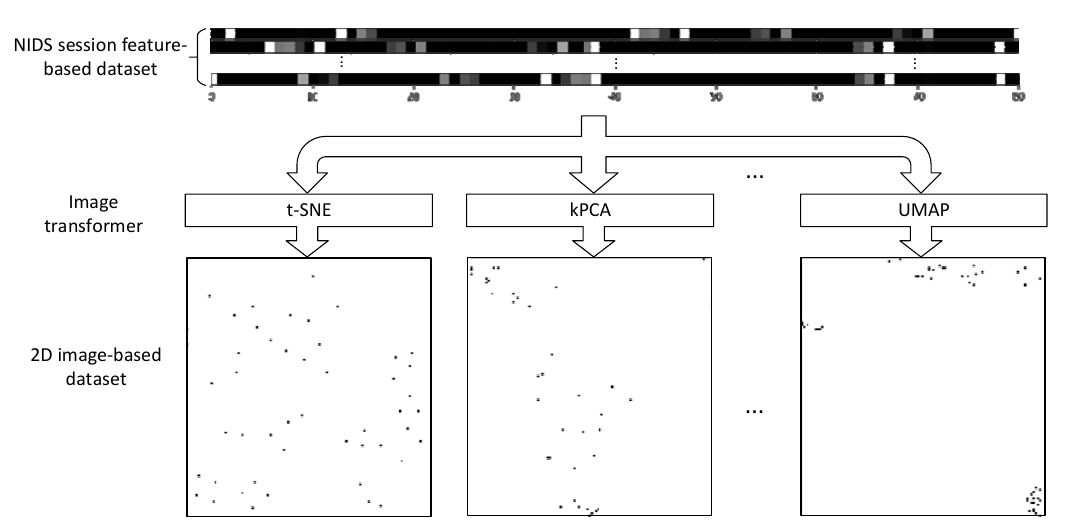
Figure 1. Results of converting NIDS datasets into 2D image-based datasets using each image trans- former.